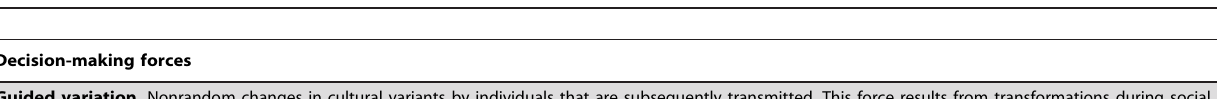
Table 1. Plausible learning biases important to economic processes – decision-making and biased-transmission learning strategies (from